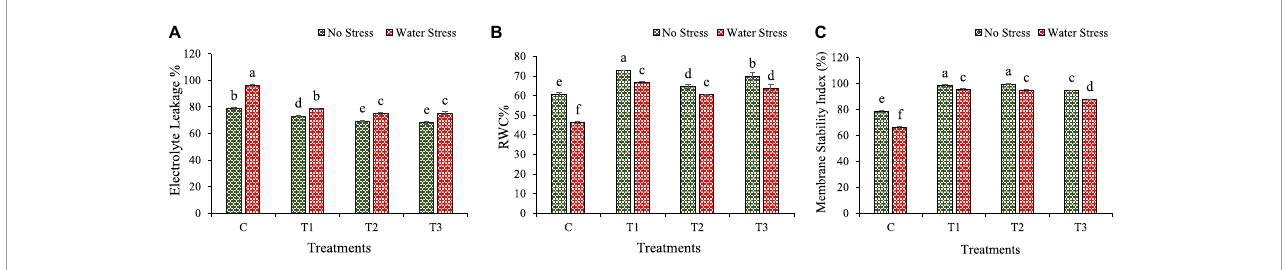
FIGURE6 Impacts of bacterial treatments (T1 — Enterobacter cloacae BHUAS1, T2 — Bacillus megaterium BHUIESDAS3, and T3 — Bacillus cereus BHUAS2) on various features of wheat plants under the influence of water-induced drought stress (A) electrolyte leakage (EL), (B) relative water content (RWC), and (C) membrane stability index (MSI). The different alphabets indicate statistically significant differences between each treatment (DMRT p < 0.05).